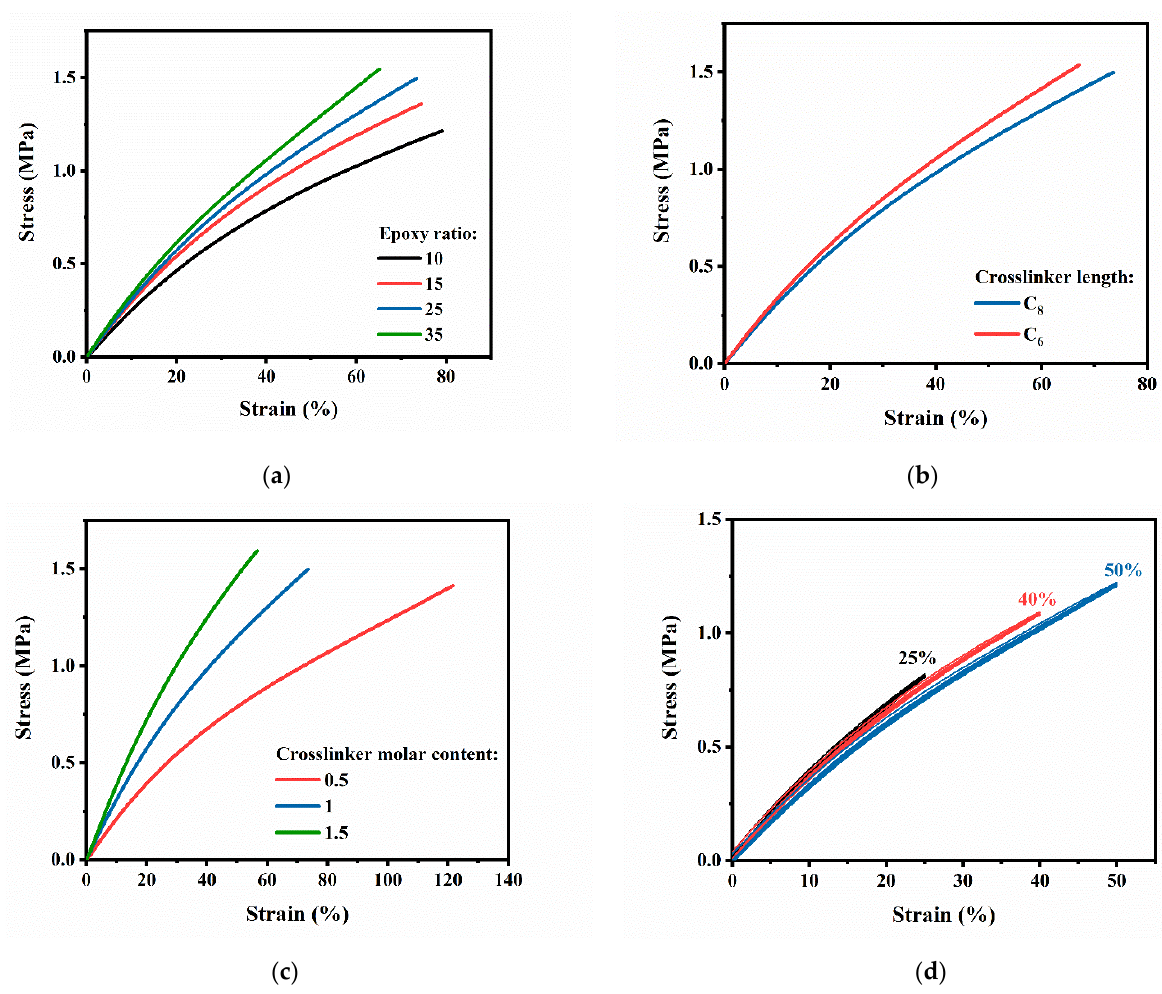
Figure 3. Typical stress–strain curves for PB vitrimers with the modification of network parameters: ( a ) epoxy ratio, ( b ) crosslinker length, and ( c ) crosslinker molar content; ( d ) stress–strain curves of vitrimer 4 for five repeated cycles.